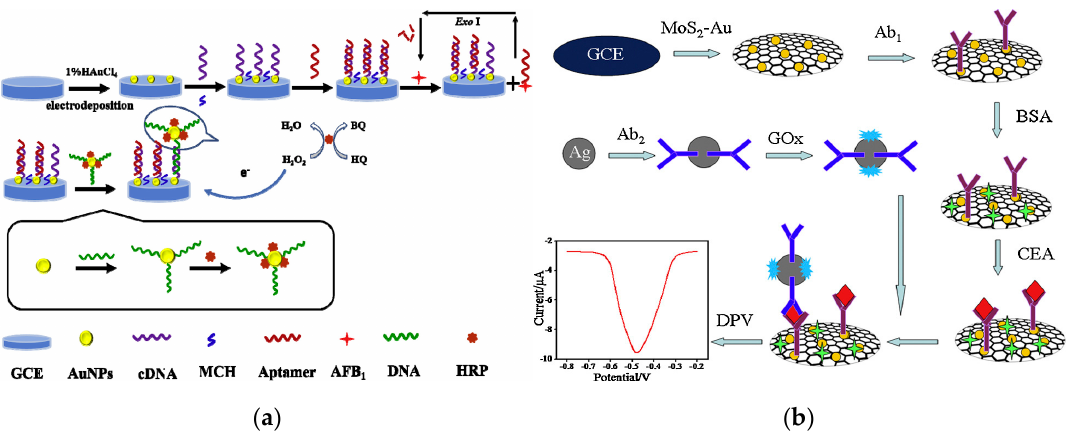
Figure 11. ( a ) Electrochemical aptasensor based on DNA-AuNPs-HRP nanoprobes for detection of